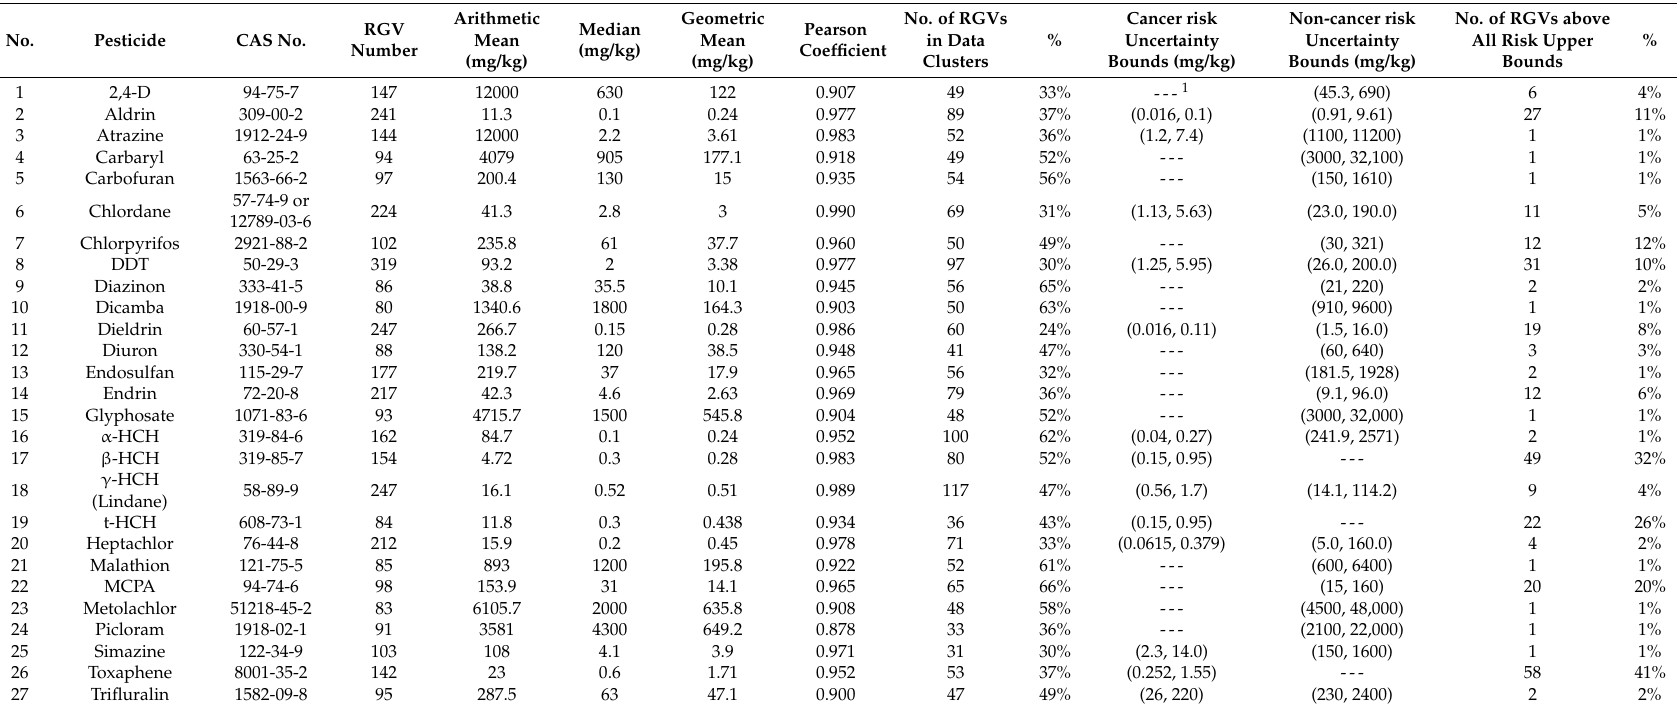
Table 5. Statistical summary of the RGVs for the commonly regulated